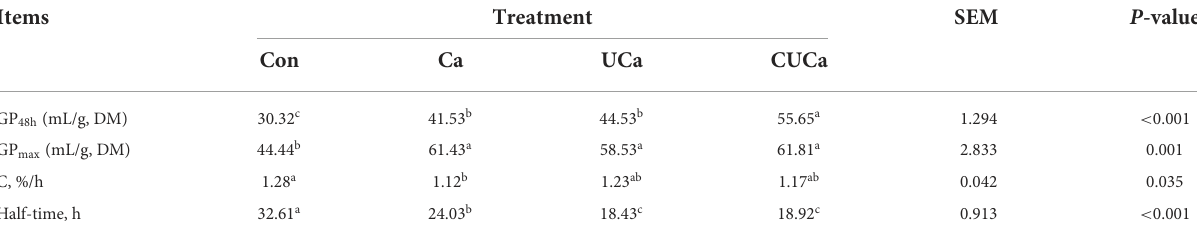
TABLE 3 Effect of CSL plus urea-alkali pretreatment on gas production characteristics of rice straw.